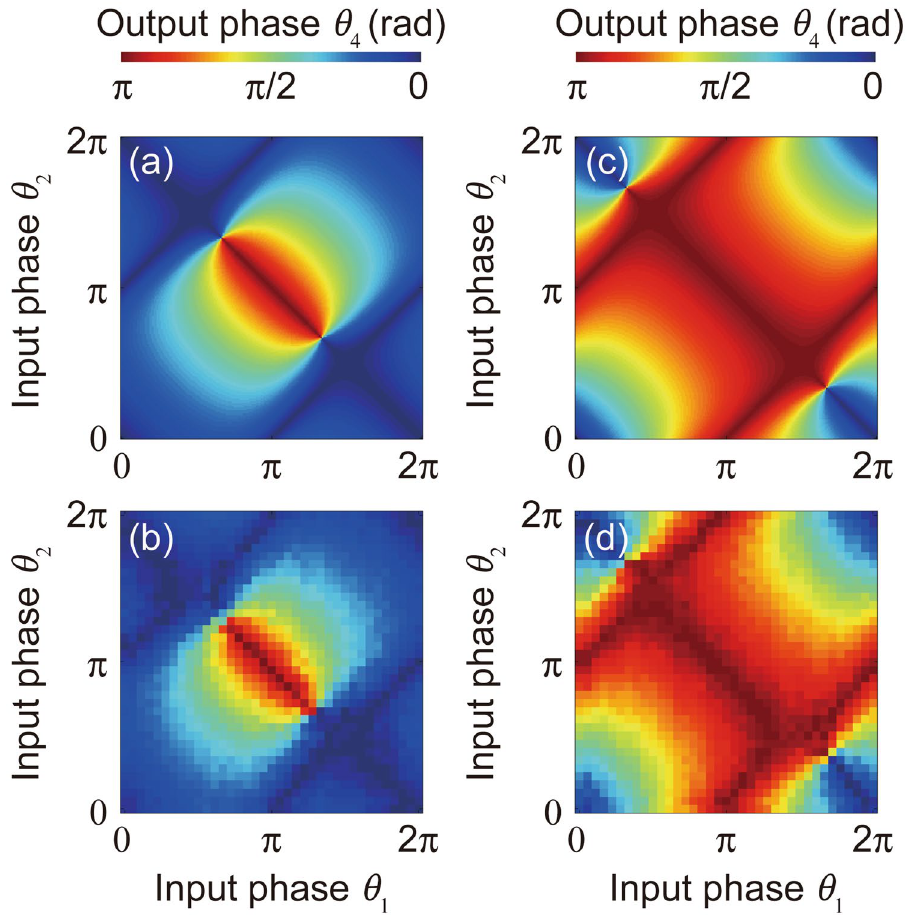
Figure 2. Logical output dependences for all combinations of input phases. Logical output dependence for all combination of input phases. Output phase θ 4 dependence for AND-operation configuration obtained by ( a ) calculation and ( b ) experiment, and that of OR-operation configuration obtained by ( c ) calculation and ( d ) experiment. Colour represents the amount of phase